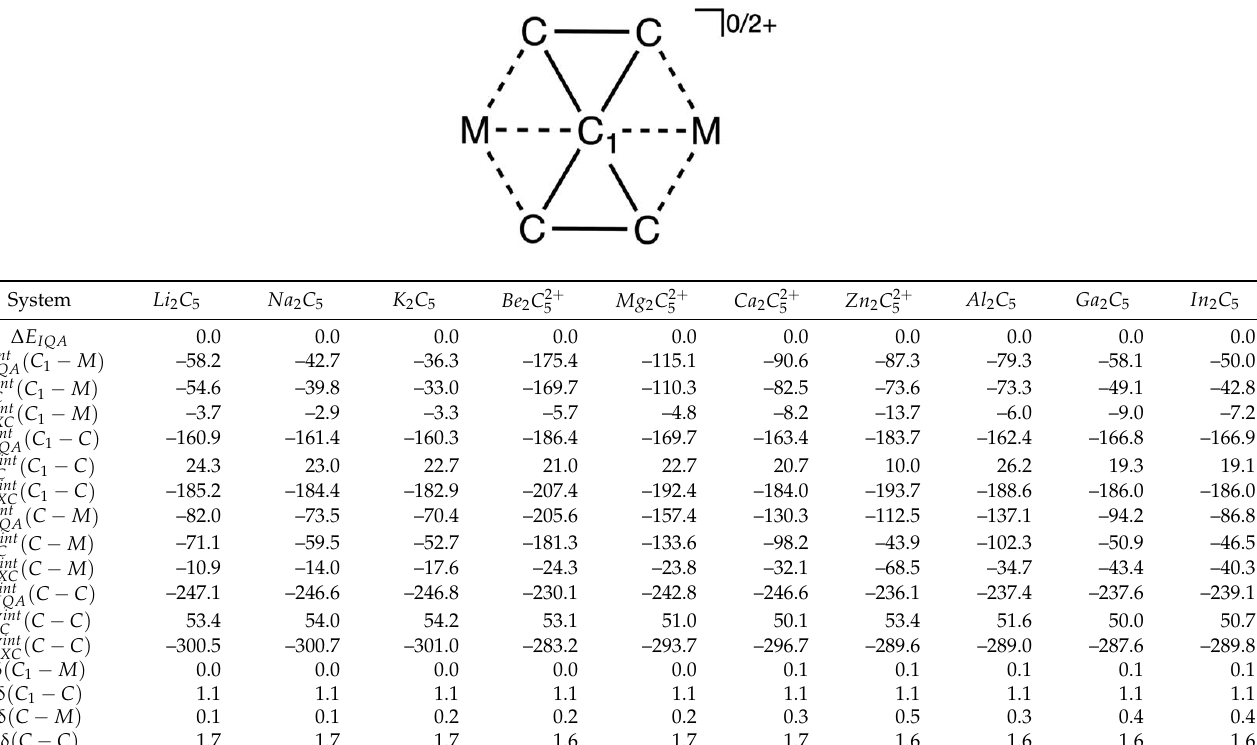
Table 2. Energy components (in kcal·mol −1 ) of IQA for the M 2 C 50/2+ (M = Li-K, Be-Ca, Al-In, and Zn) computed at the ωb97XD/Def2 -TZVP level. 𝑉 𝐼𝑄𝐴𝑖𝑛𝑡 , 𝑉 𝐶𝑖𝑛𝑡 , and 𝑉 𝑋𝐶𝑖𝑛𝑡 are interatomic IQA interaction energy and their coulombic and exchange-correlation energy components, respectively. ∆𝐸 𝐼𝑄𝐴 is the total integration error in IQA energies, and the delocalization indices are represented by δ .